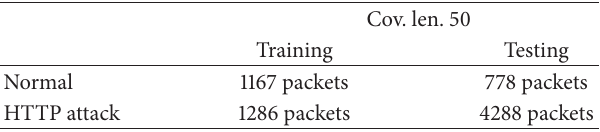
Table 5: Number of samples in cov. len. 150.